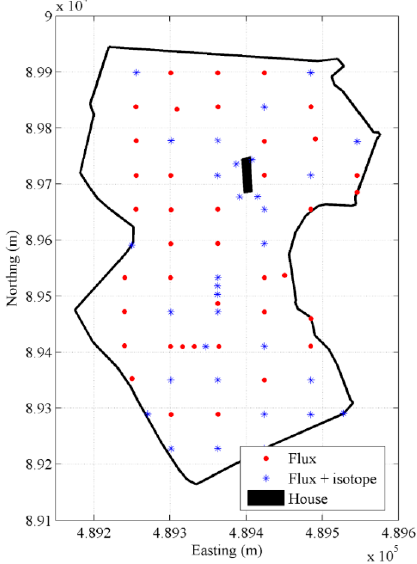
Figure 2. Godin site showing flux and isotope sampling locations. All coordinates are in Pennsylvania State plane coordinates.